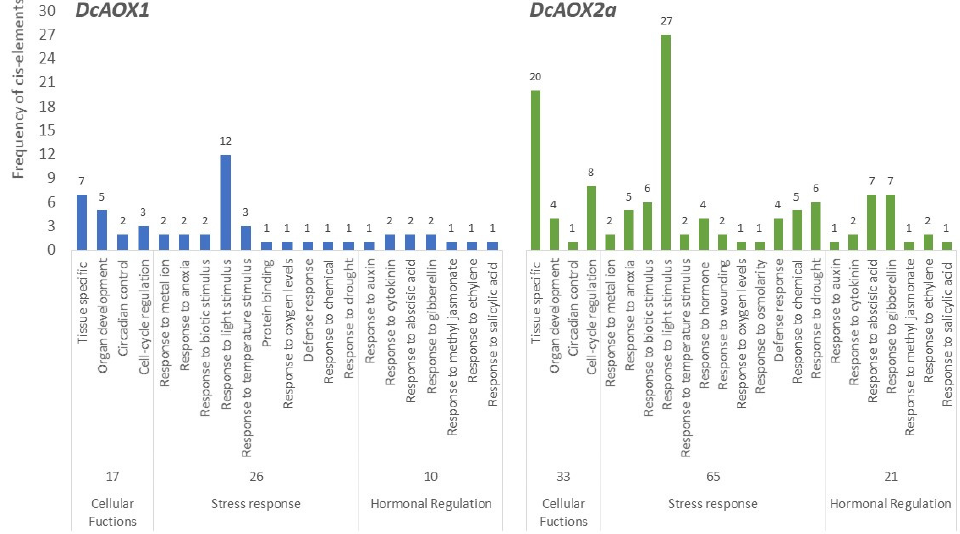
Figure 7. Frequency of cis -regulatory motifs identified in 2.0 Kb promoter region of both DcAOX genes ( DcAOX1 and DcAOX2a ) using New PLACE and PlantCARE